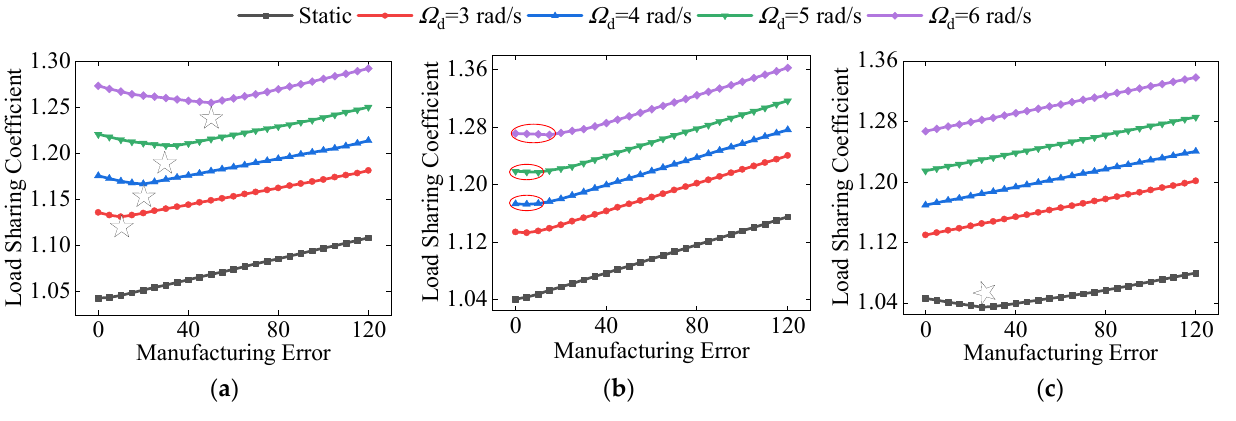
Figure 26. Influence of gear manufacturing eccentricity error on LSC at different LAV. ( a ) Sun gear; ( b ) Planet gear; ( c ) Ring gear.